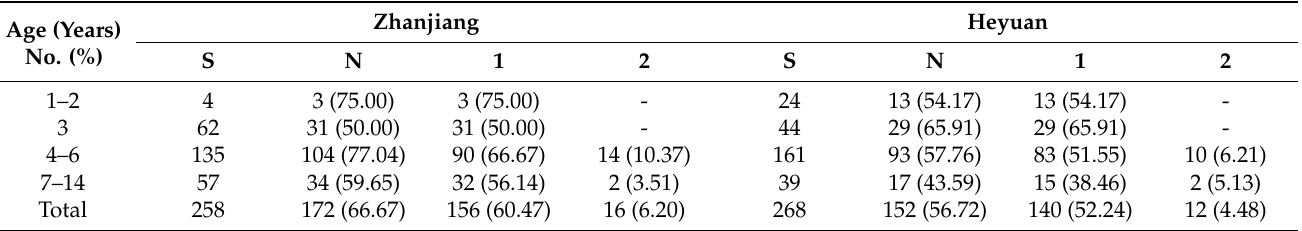
Table 2. The coverage of the varicella vaccine for participants aged 1–14 years in both cities.